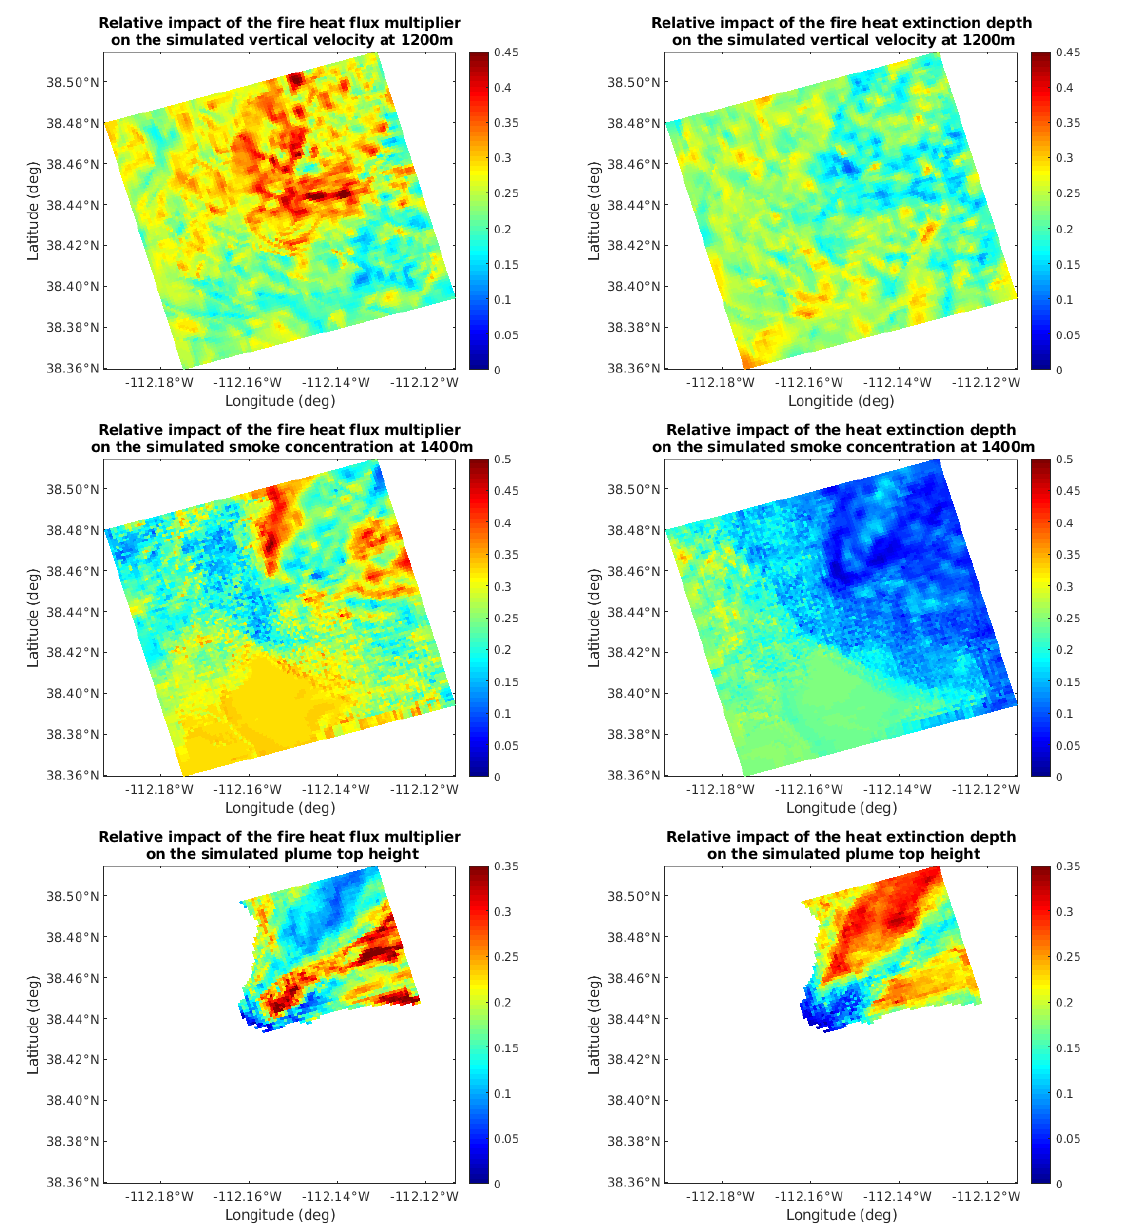
Figure 16. Sensitivity of the vertical velocity at 1200 m ( top ), smoke concentration at 1400 m ( middle ), and plume top height ( bottom ) to the fire heat flux multiplier ( left column) and the heat extinction depth ( right